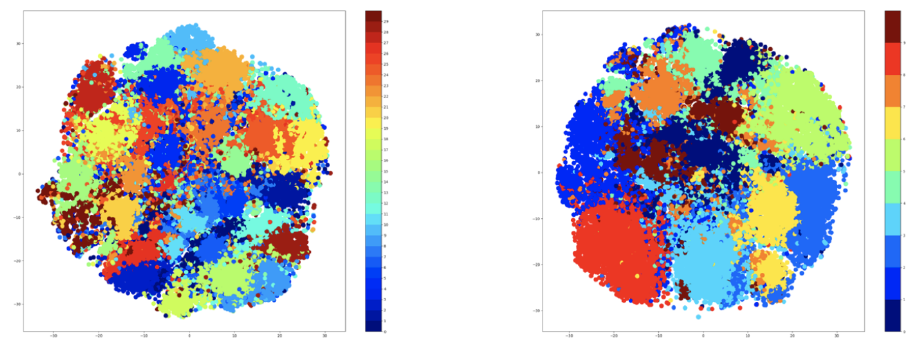
Figure 10. Plotting the t-SNE of encoded features with GMM; 30 clusters ( left ); 10 clusters ( right ).